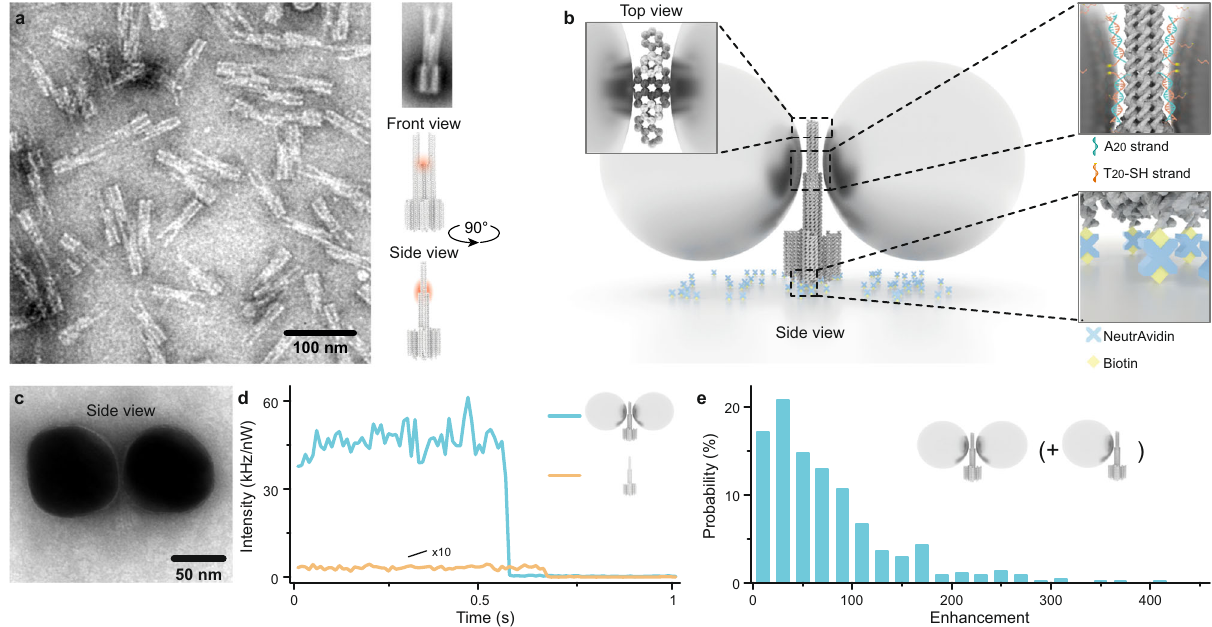
Fig. 1 Concept of the DNA origami nanoantenna with a cleared hotspot. a TEM image (left, reproduced at least 3 times) and sketches (right) of the DNA origami structure used for the nanoantenna assembly with the position of the plasmonic hotspot indicated in red. A representative class averaged TEM image of the DNA origami used is shown on the upper right. b Schematics of NACHOS assembly: the DNA origami construct is bound to the BSA-biotin coated surface via biotin-NeutrAvidin interactions, thiolated DNA-functionalized 100 nm silver particles are attached to the DNA origami nanoantenna via polyadenine (A 20 ) binding strands in the zipper-like geometry to minimize the distance between the origami and the nanoparticles 30 . c TEM image of a NACHOS with 100 nm silver nanoparticles (reproduced at least 3 times). d Single-molecule fl uorescence intensity transients, measured by confocal microscopy, normalized to the same excitation power of a single Alexa Fluor 647 dye incorporated in a DNA origami (orange) and in a DNA origami nanoantenna with two 100 nm silver nanoparticles (blue) excited at 639 nm e . Fluorescence enhancement distribution of Alexa Fluor 647 measured in NACHOS with 100 nm silver nanoparticles. A total number of 164 and 449 single molecules in the reference (more examples are provided in Supplementary Fig. 3) and NACHOS structures were analyzed,